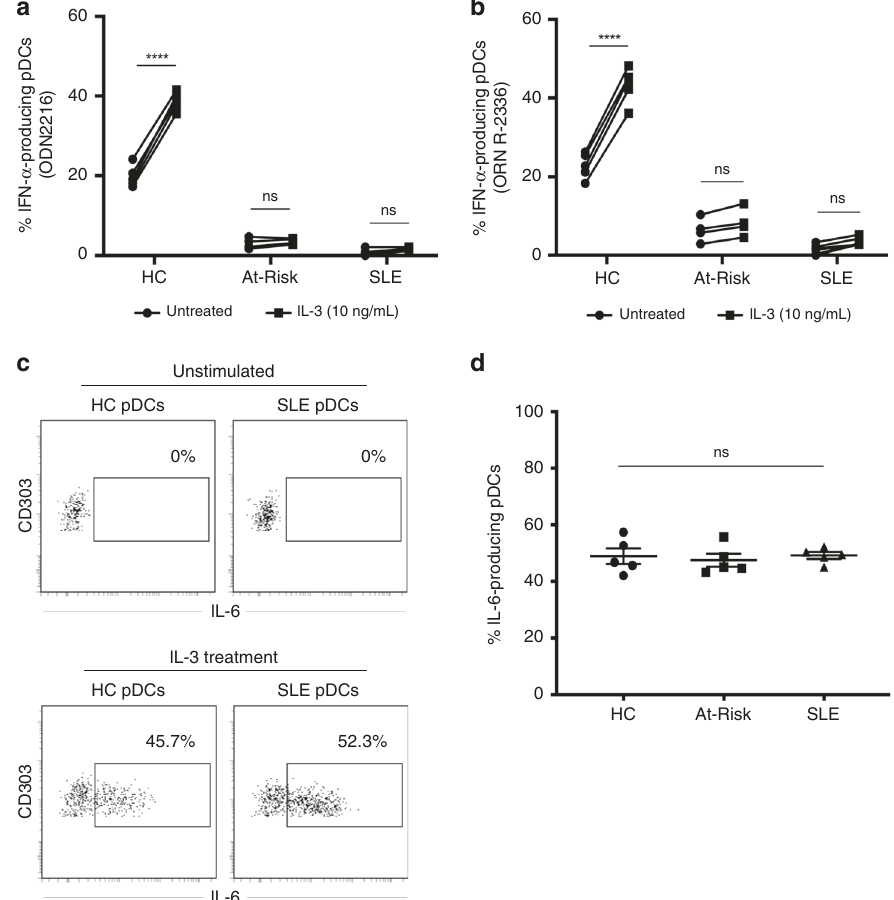
Fig. 3 IL-3 triggers TLR-independent production of IL-6 by pDCs. PBMCs from healthy controls (HC; n = 6), At-Risk individuals (At-Risk; n = 4), and SLE patients ( n = 7) were cultured for 18 h in the absence or presence of IL-3 (10 ng/mL). The cells were then stimulated by TLR9 (ODN 2216) or TLR7 (ORN R-2336) agonists for six additional hours. The production of cytokines was measured by intracellular staining. a IL-3 signi fi cantly enhanced TLR9-mediated IFN- α production by pDCs of healthy controls ( P < 0.0001); this effect was not seen in pDCs of At-Risk ( P = 0.94) and SLE ( P = 0.53) patients. b IL-3 signi fi cantly enhanced TLR7-mediated IFN- α production by pDCs of healthy controls ( P < 0.0001); this effect was not that prominent in pDCs of At-Risk ( P = 0.71) and SLE ( P = 0.43) patients. c Treatment with IL-3 (10 ng/mL) induced the production of IL-6 by pDCs of both healthy controls and SLE patients without exogenous TLR stimulation. d No difference was found in IL-6 production by the pDCs of healthy controls, At-Risk individuals, and SLE patients after stimulation with IL-3. The production of IL-6 was detected by intracellular staining. Data are represented as mean ± SEM. *** P < 0.001; ns = not signi fi cant. Two-way ANOVA ( a – d with active SLE, At-Risk individuals, and healthy controls with allogeneic naive CD4 + T cells in the presence of low ratio anti- CD3/CD28 beads for 5 days before adding PMA/Ionomycin in the last 5 h of the culture. In comparison with T cells alone, pDCs from healthy controls enhanced the production of TNF (34.07%